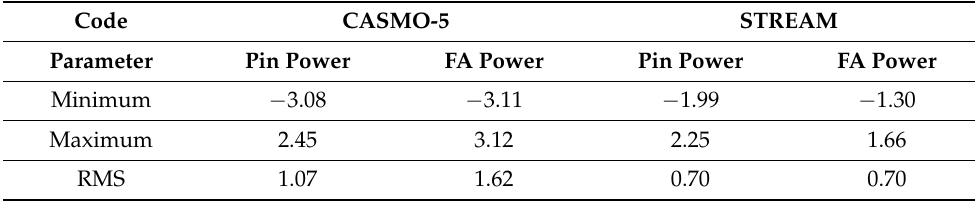
Table 5. Relative power difference compared with Serpent